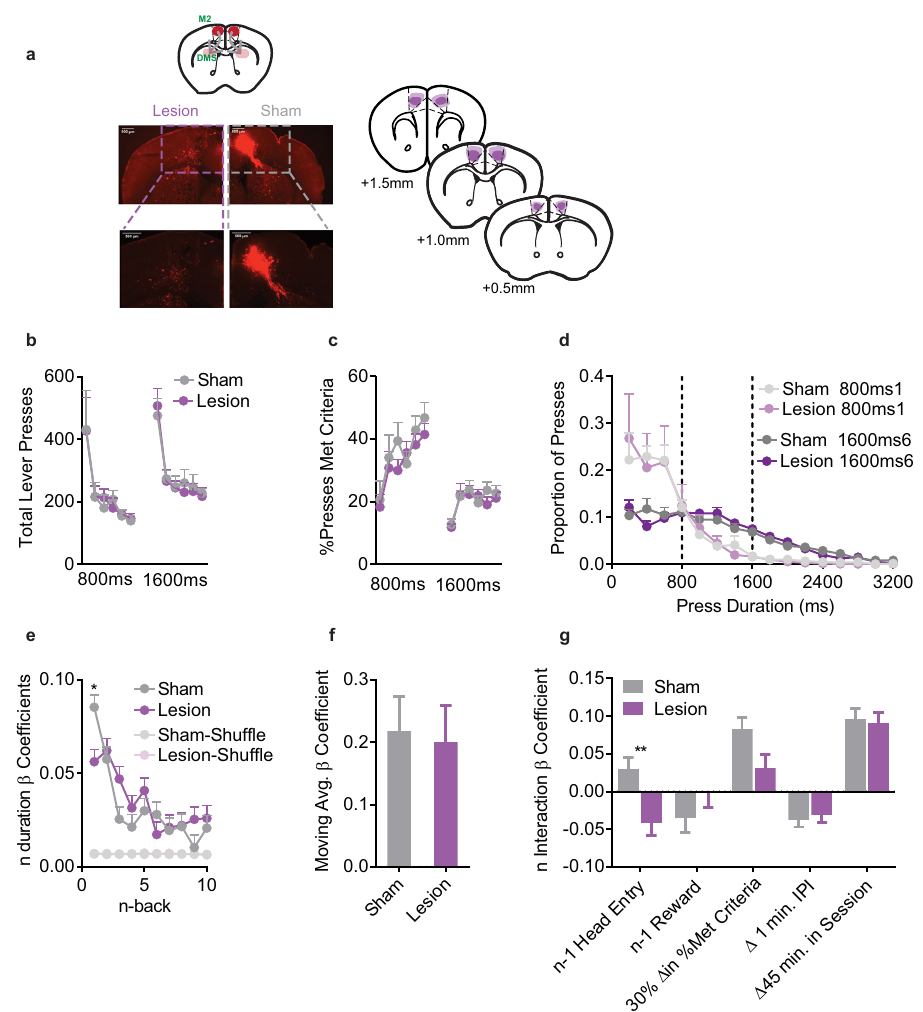
Fig. 6 Pretraining M2-DMS lesions impair use of recent experience. a (top) Schematic, (bottom) example histology and (right) average/maximal (dark/ light shading) spread of projection speci fi c M2-DMS lesion using a Cre-dependent caspase strategy, slice coordinates relative to Bregma. b Total Lever Presses across training days. c %Presses that met criteria across training days. d Histogram of lever press durations on the fi rst and last days of the 800 ms and 1600ms criteria (200 ms bins). e β coef fi cient from LME models predicting n duration from n-back durations for Actual and order Shuf fl